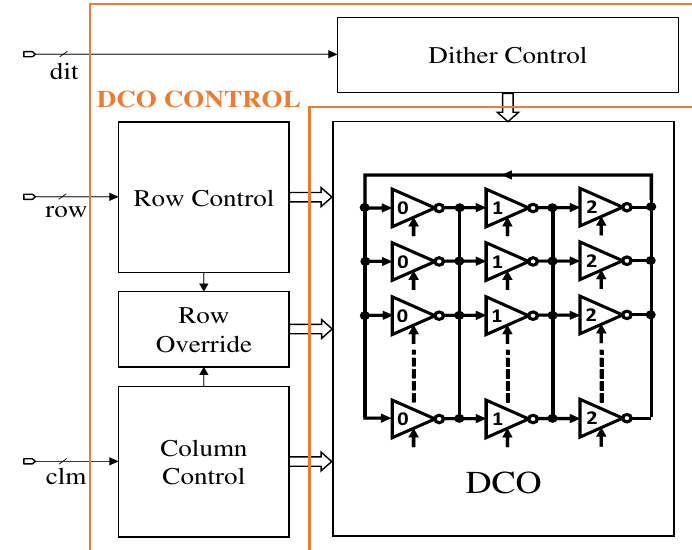
Figure 5. Block diagram of controller-based